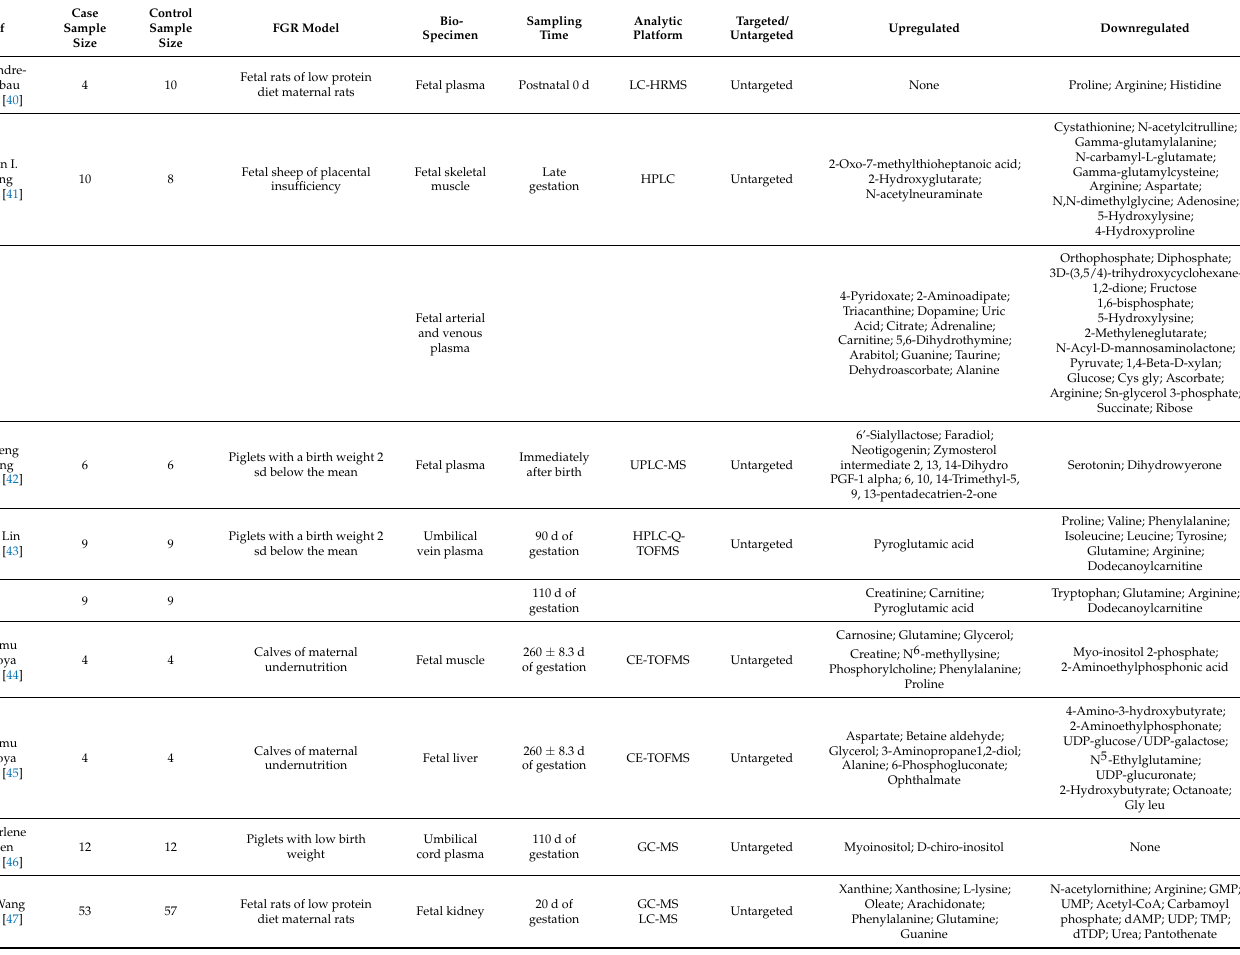
Table 5. Characteristics of the Animal Studies.